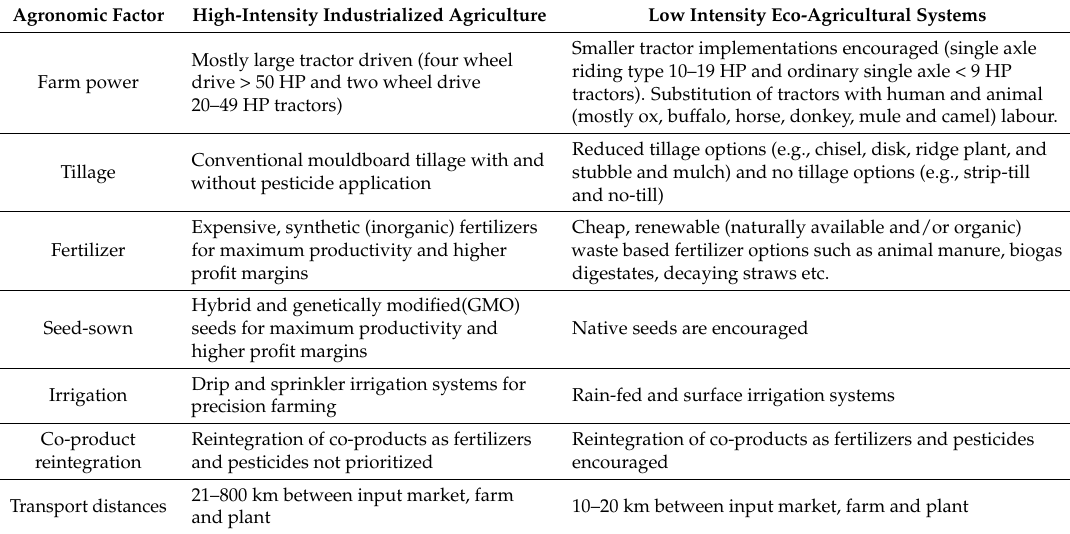
Smaller tractor implementations encouraged (single axle riding type 10–19 HP and ordinary single axle < 9 HP tractors). Substitution of tractors with human and animal (mostly ox, buffalo, horse, donkey, mule and camel) labour. Reduced tillage options (e.g., chisel, disk, ridge plant, and stubble and mulch) and no tillage options (e.g., strip-till and no-till) Cheap, renewable (naturally available and/or organic) waste based fertilizer options such as animal manure, biogas digestates, decaying straws etc. Native seeds are encouraged Rain-fed and surface irrigation systems